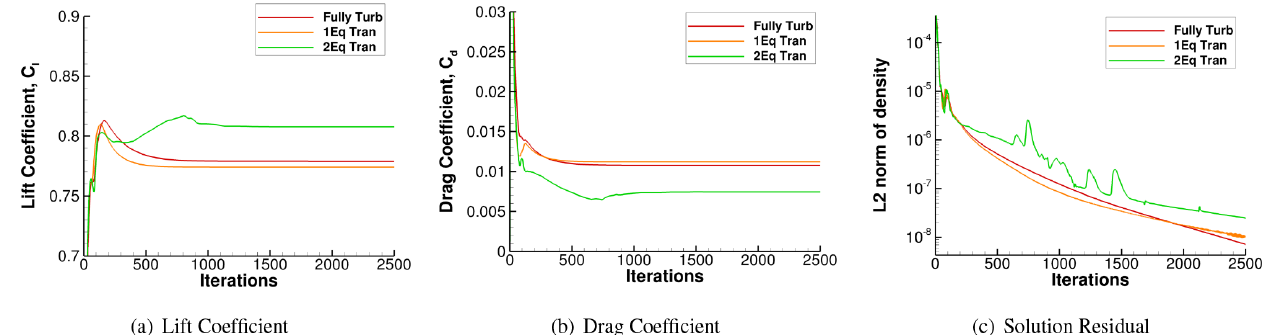
Figure C2. Solution convergence history during simulations for the DU-00-W212 airfoil at α = 4 ◦ and Re = 9 × 10 6 .